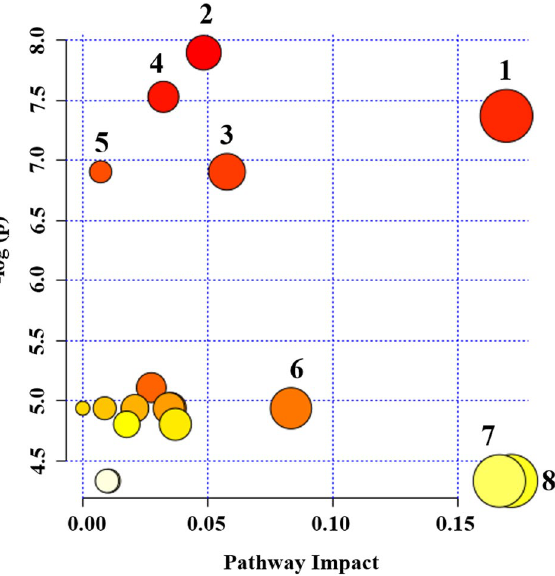
Figure 4. Summary of pathway analysis of IEI-EMF group compared to Controls. Plot was obtained by using MetaboAnalyst 4.0. “X axis” represents the impact of the identified metabolites on the indicated pathway. “Y axis” indicates the extent to which the designated pathway is enriched in the identified metabolites. Circle colors indicate pathway enrichment significance. Circle size indicates pathway impact. 1 , Glycine, serine and Threonine metabolism; 2 , Aminoacyl-tRNA biosynthesis; 3 , Nitrogen metabolism; 4 , Glutathione metabolism; 5 , Purine metabolism; 6 , Cyanoaminoacid metabolism; 7 , Alanine, aspartate and glutamate metabolism and 8 , d-glutamine and d-glutamate